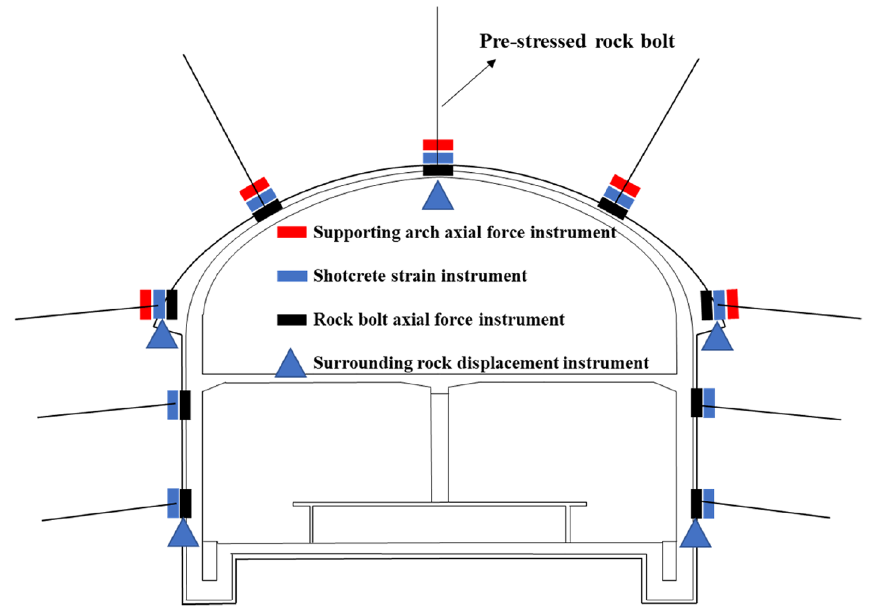
Figure 20. Type and layout of monitoring